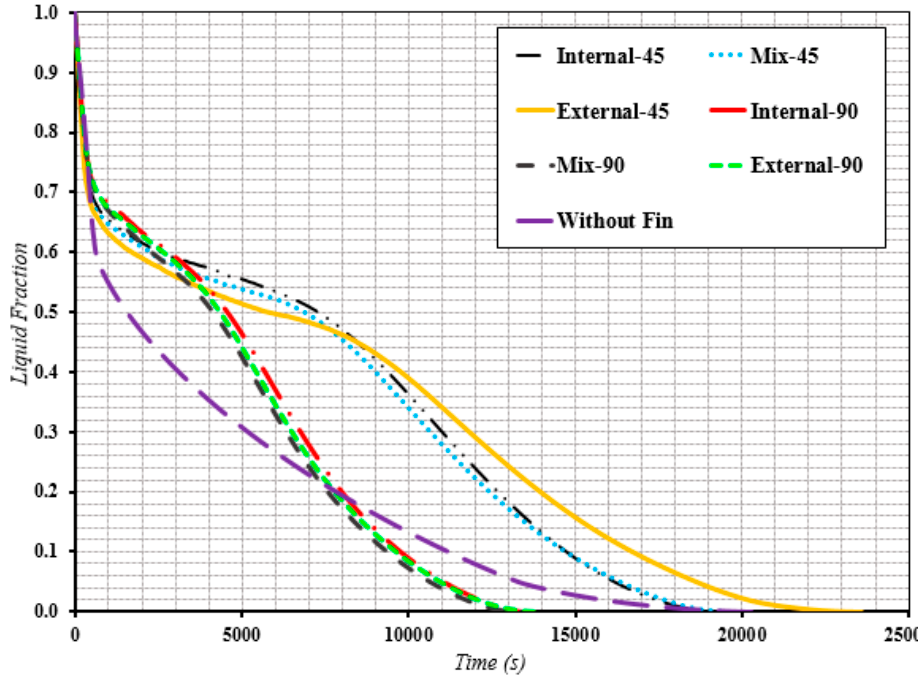
Figure 8. The average liquid fraction of the PCM area with different fins configurations with the same dimensions (1 mm × 42 mm) during the time.